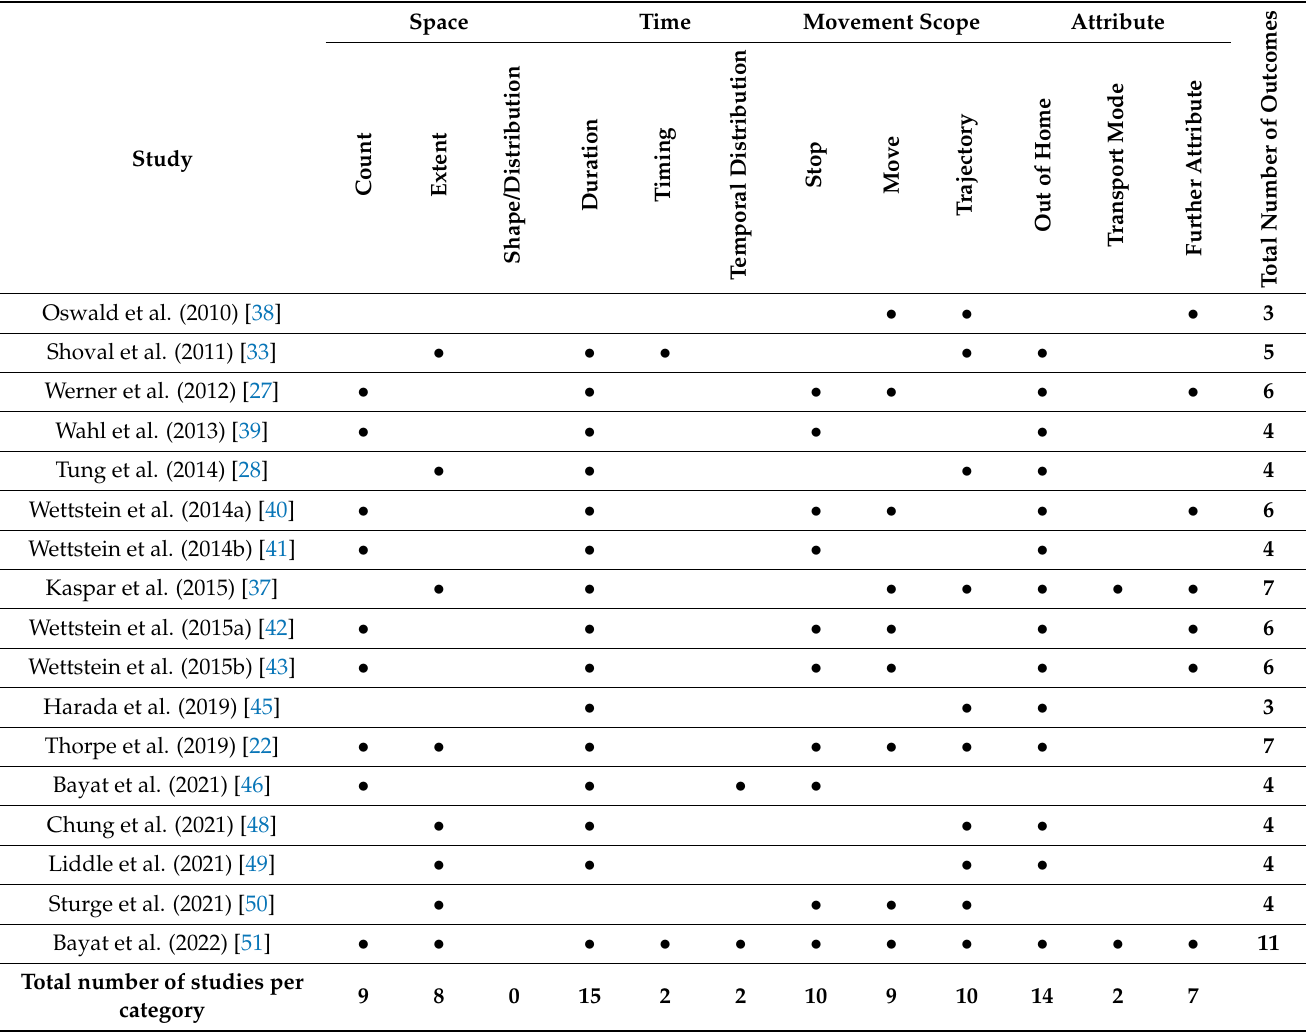
Table 2. Characterisation of dementia studies based on the GPS-derived mobility indicators used, according to the characteristic aspects of the conceptual framework by Fillekes et al. [34], where mobility indicators are classified based on their analytical and characteristic aspects, which are then grouped into further thematically organized